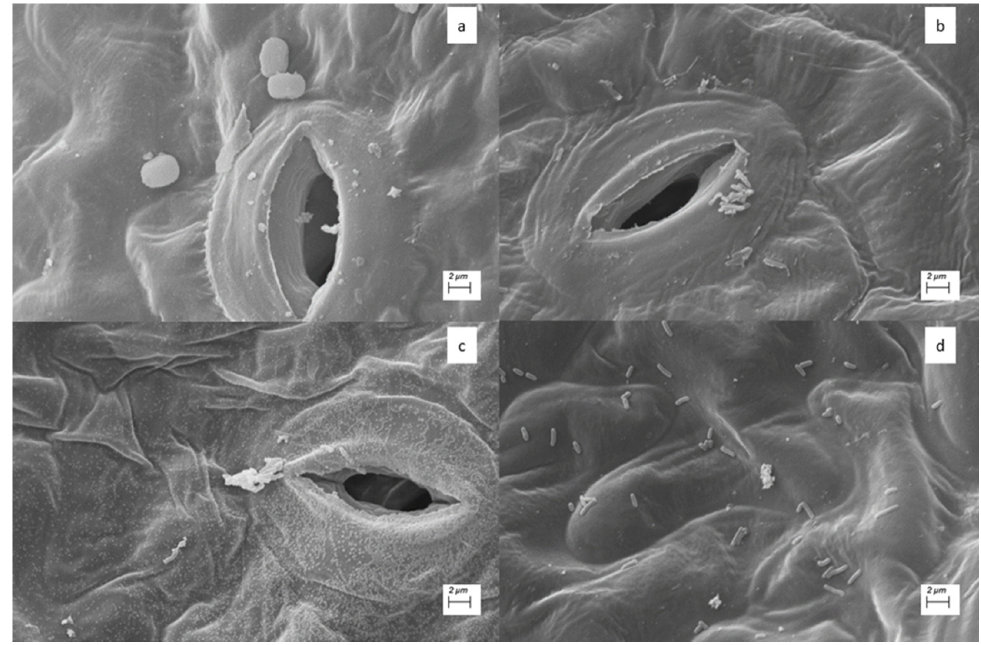
Figure 7. Electron micrograph of the ‘PDW’ rootstock. Acinetobacter ursingii strain 24 ( a ); Acinetobacter ursingii strain 26 ( b ); no inoculation no IBA ( c ); syntetc auxin (IBA) ( d ).